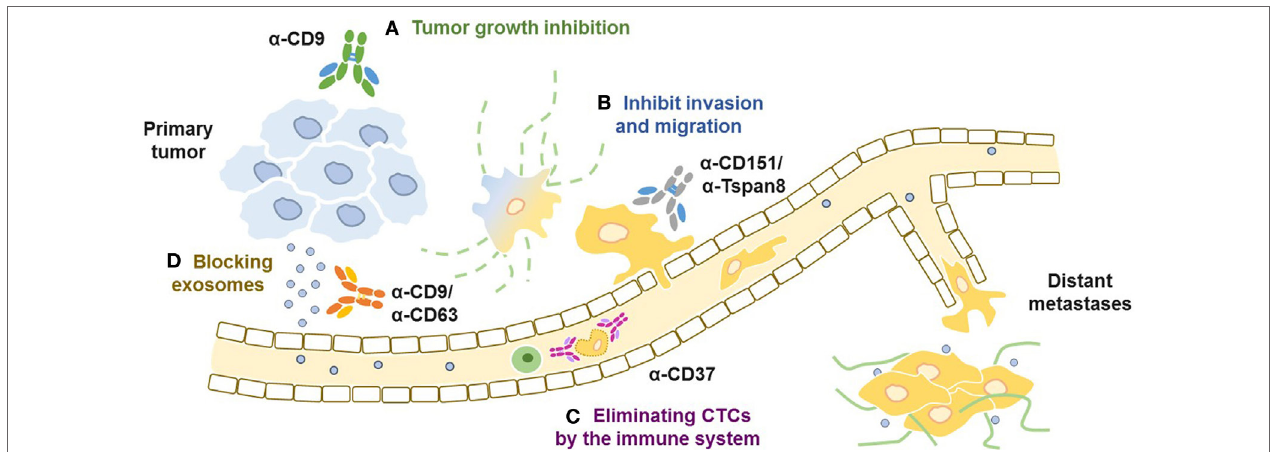
FiGURe 2 | Targeting tetraspanins at different stages of tumor progression. (A) Anti-CD9 antibodies have been shown to inhibit proliferation of human gastric tumors (B) anti-Tspan8 and anti-CD151 antibodies which inhibit adhesion, migration, and extravasation of tumor cells in different types of cancer in vitro and in vivo . (C) Anti-CD37 antibodies eliminates circulating chronic lymphocytic leukemia cells by recruiting and activating the immune system, (D) anti-CD9 and anti-CD63 antibodies block exosomes and enhance their clearance from circulation through macrophage-dependent